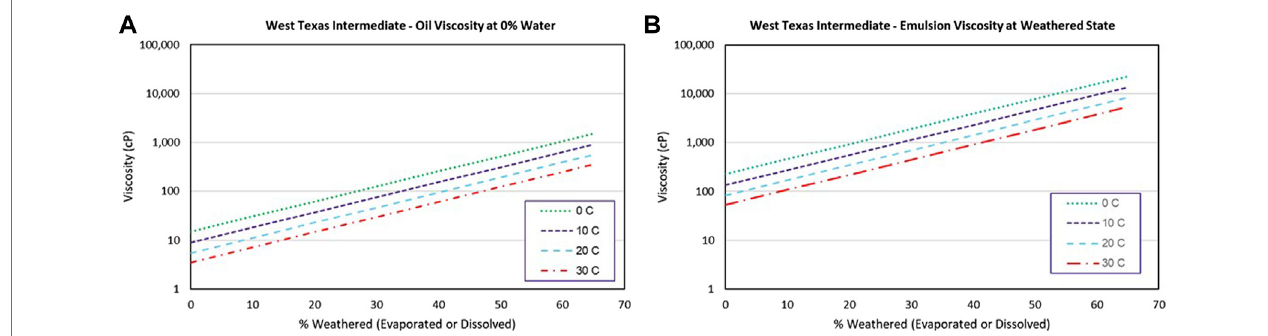
FIGURE1| Viscosityasafunctionofweathering, assuming no emulsi fi cation (A) , compared withviscosity ofthefully emulsi fi ed oilat varyingweatheringstates (B) for West Texas Intermediate oil.